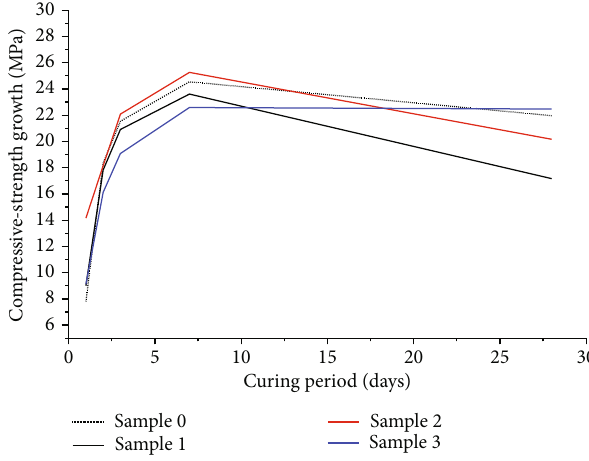
Figure 9: Compressive-strength test 2. Note: sample 0: pure cement (no additive added); sample 1: FLA A added (FLA A and SXY 0.25%BWOC); sample 2: PVAGB/FLA A added (PVAGB 0.20%BWOC, FLA A, and SXY 0.25%BWOC); sample 3: PVAGB/FLA A added (PVAGB 0.15%BWOC, FLA A, and SXY